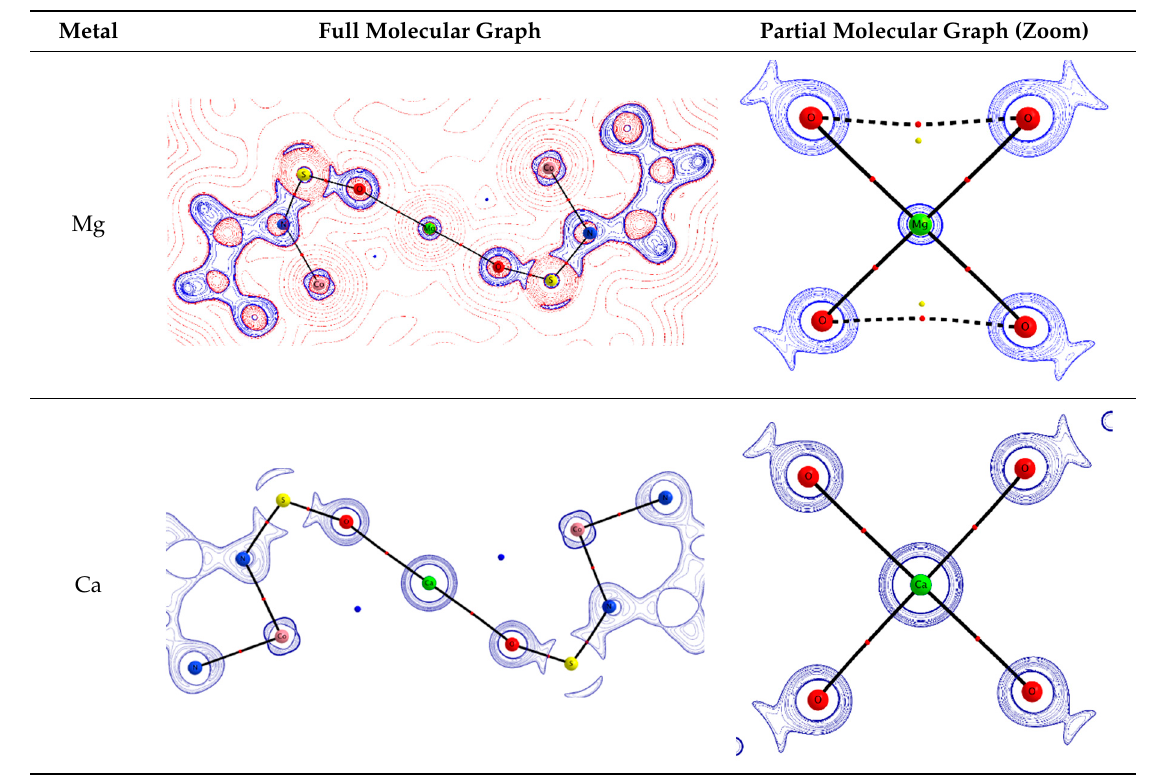
Figure 2. A contour map of the of the Laplacian operators of electron density in the plane of the Mg, Co, and oxygen donor atoms in the dimeric Co 2+ complex, [(Co(Ts 3 tren))Mg(Co(Ts 3 tren))]. The two small blue spheres are (3, +3) critical points, which are local minima of the electron density between the magnesium and cobalt atoms. Table 3. Molecular graph of the complexes.